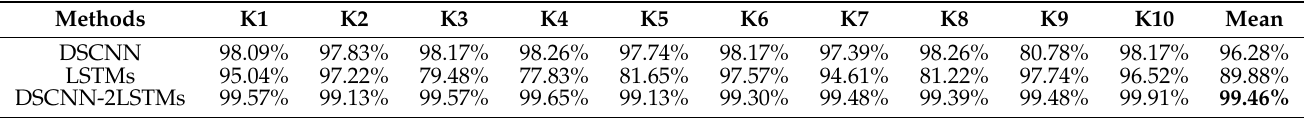
Table 7. Ablation experiment results of binary task recognition by ten-fold